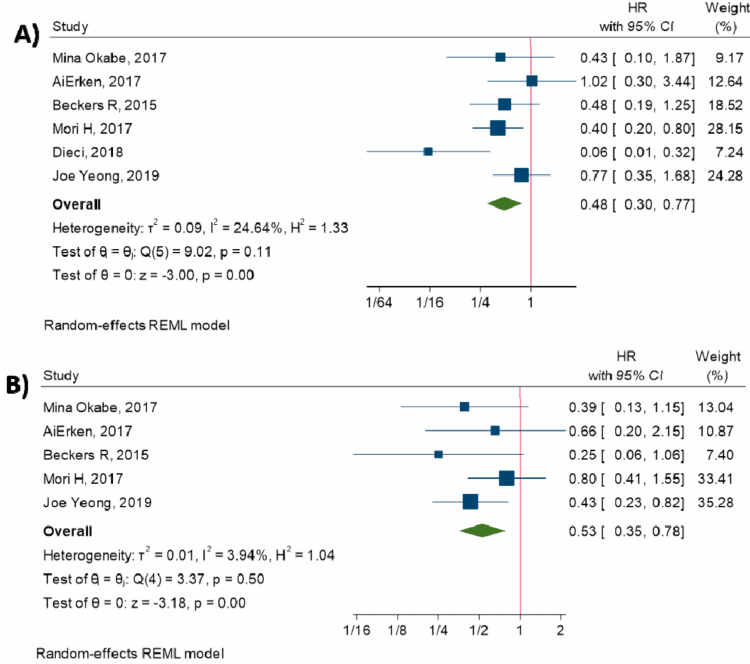
Figure 5. Forest plot of individual relative risks for TILs related survival. ( A ) OS. ( B ) DFS.